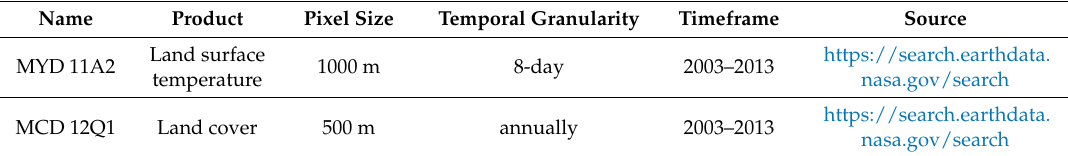
Table 2. The summarized details of remote sensing (RS) Datasets used in this